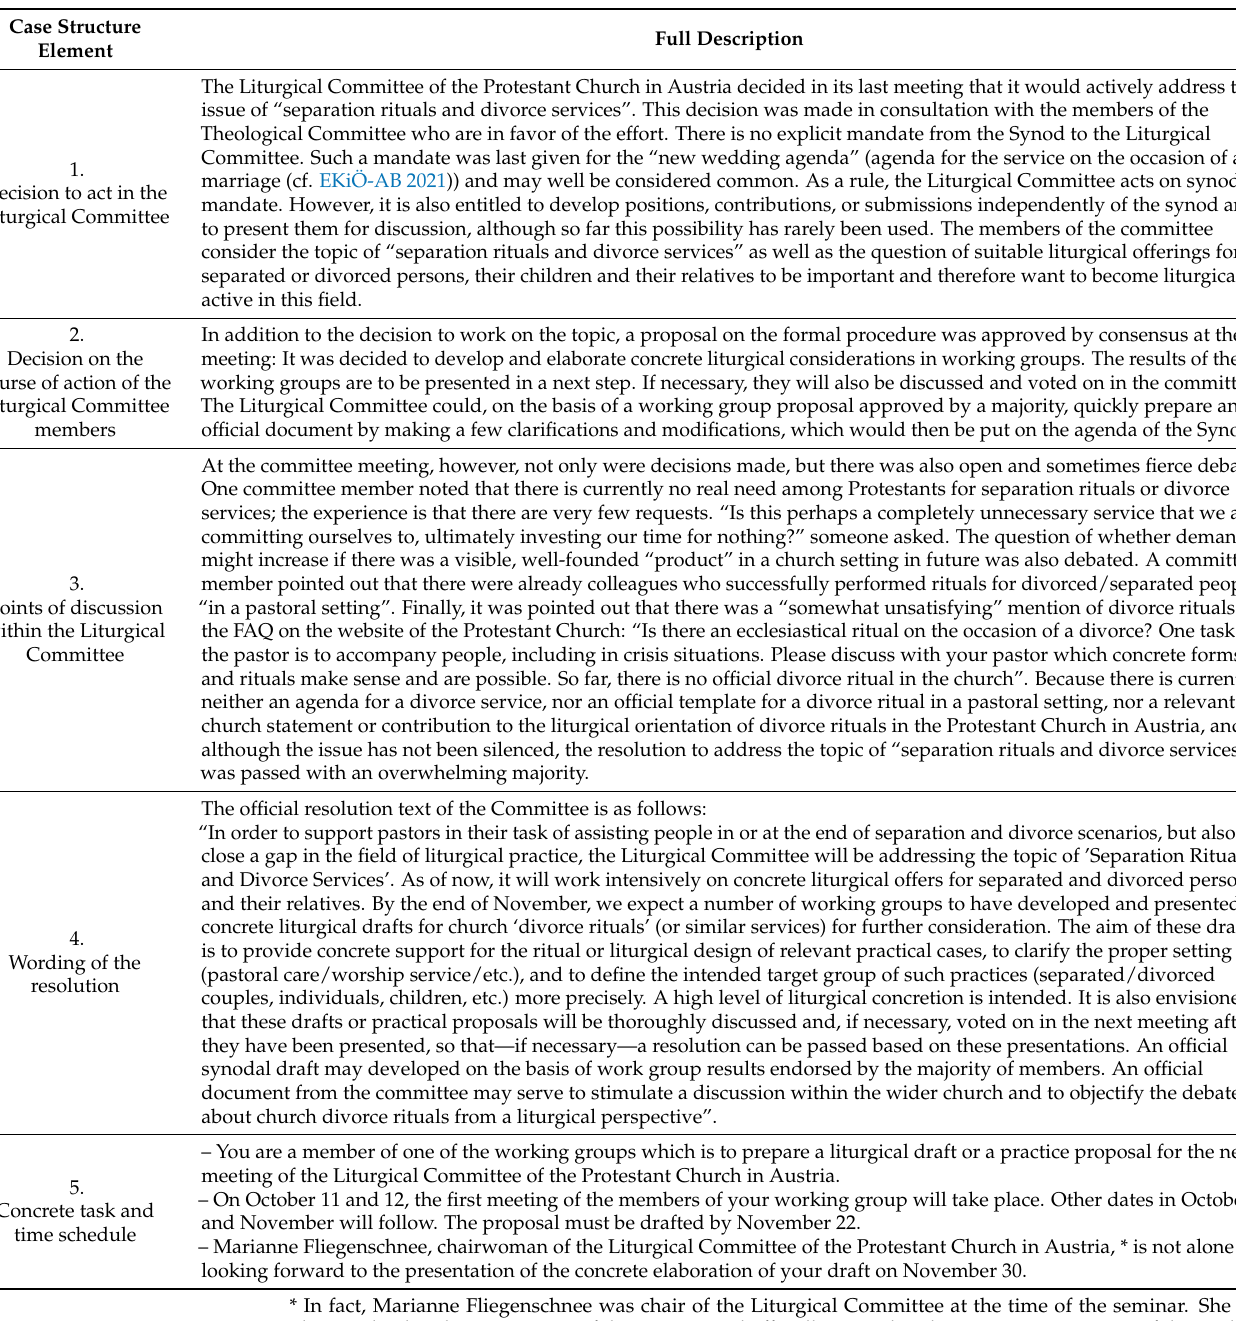
Table A1. Case description